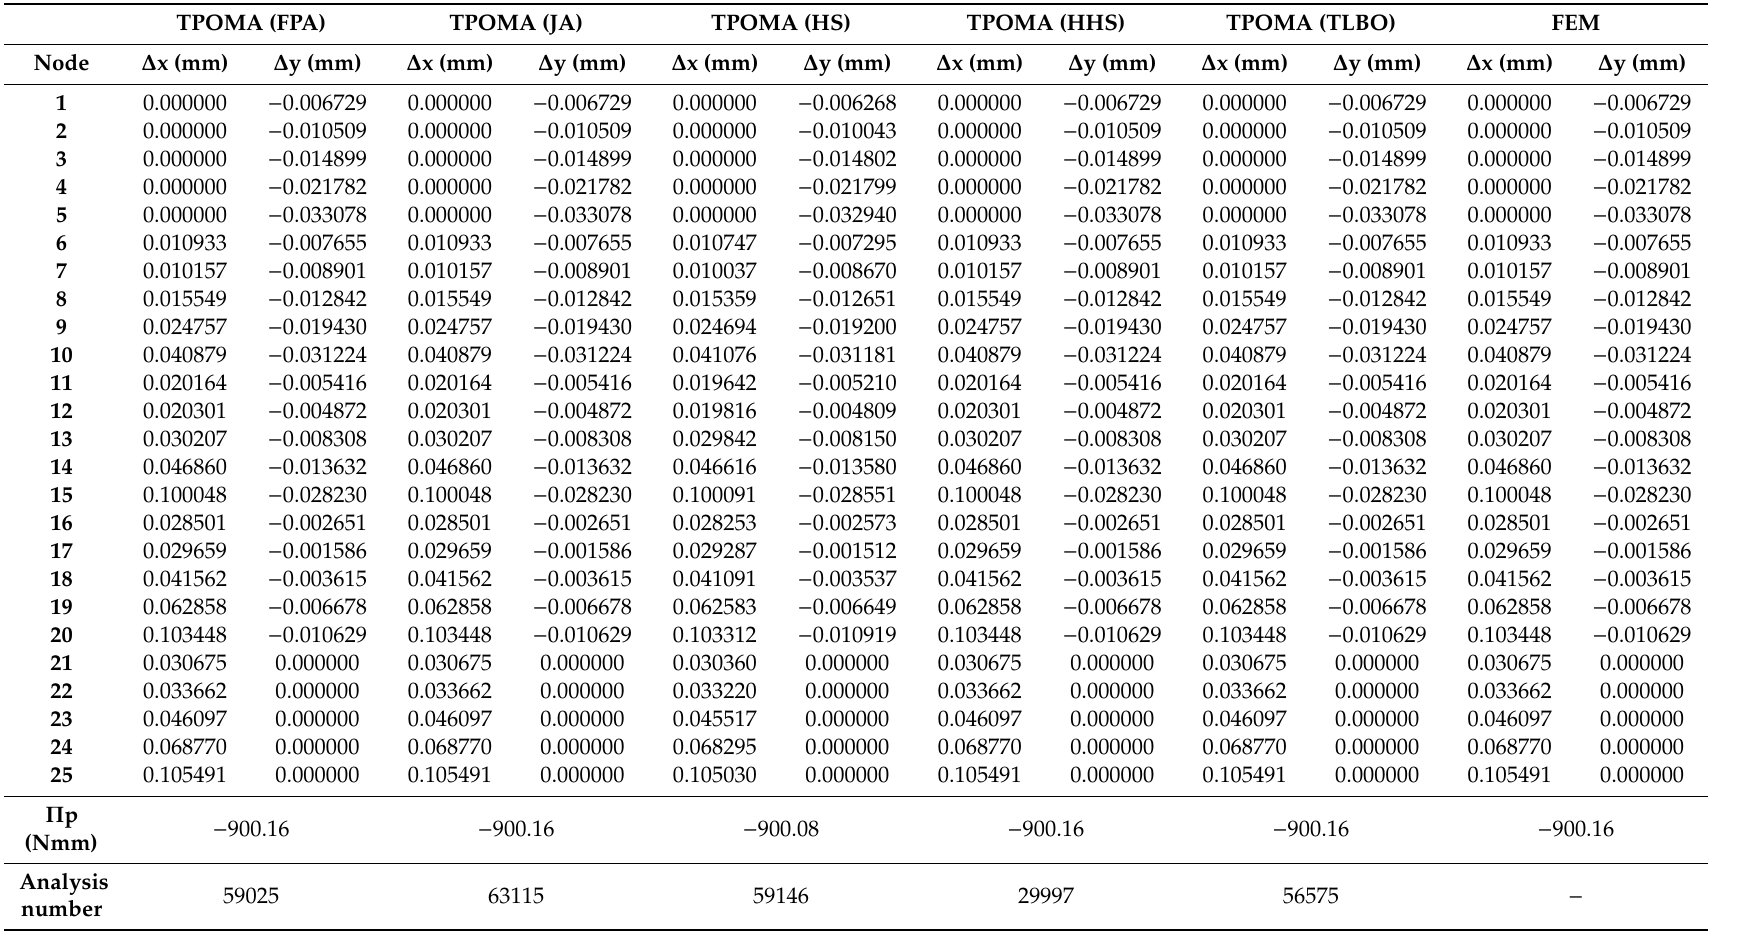
Table 2. Solutions for the plate with the hole in the middle with 32